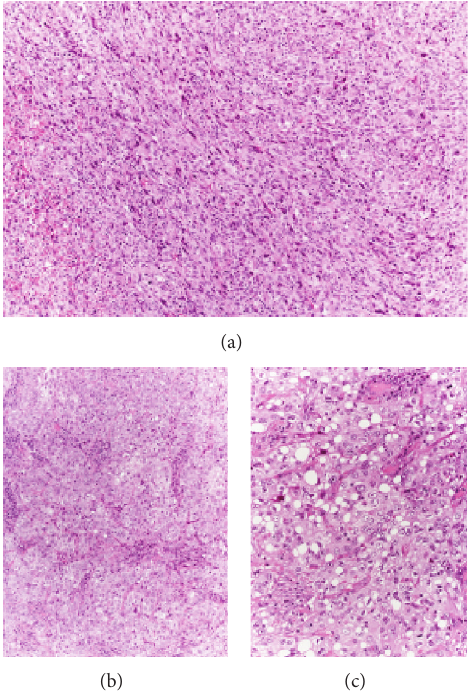
Figure 5: In the epithelioid-squamoid category, neoplastic cells show a solid (a) or nested (b) architecture. They are plump and have abundant cytoplasm with a variable degree of squamous differentiation (c).